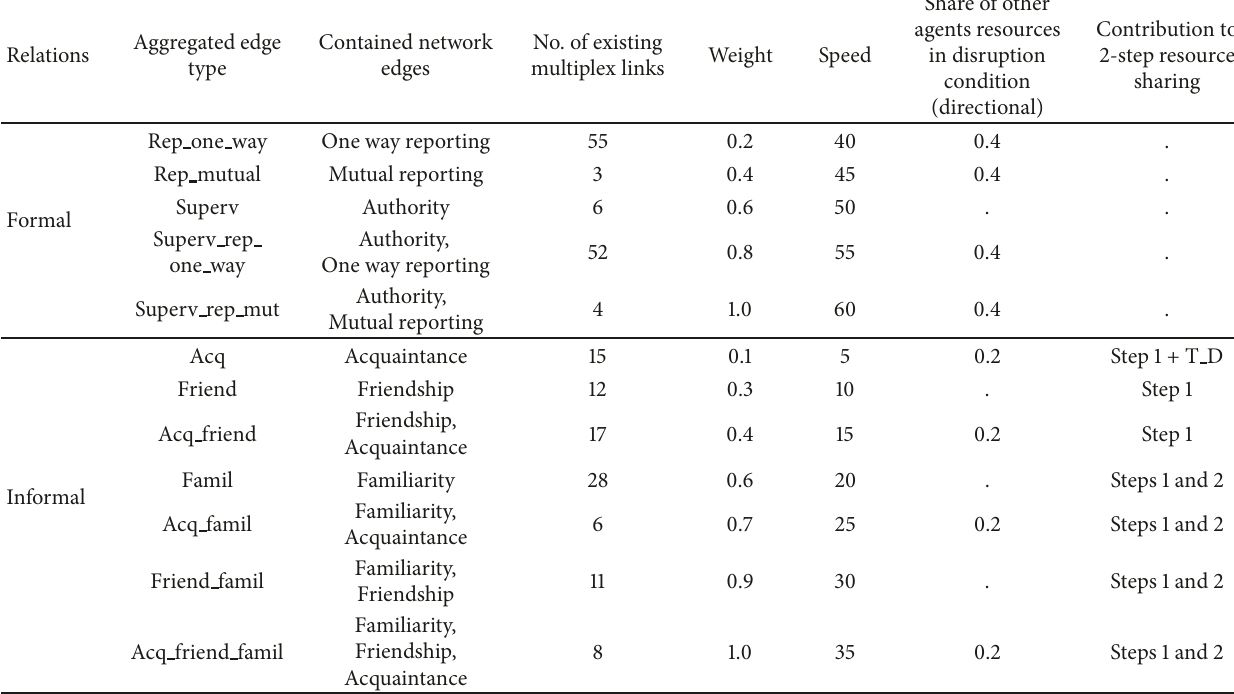
Table 3: Simulation